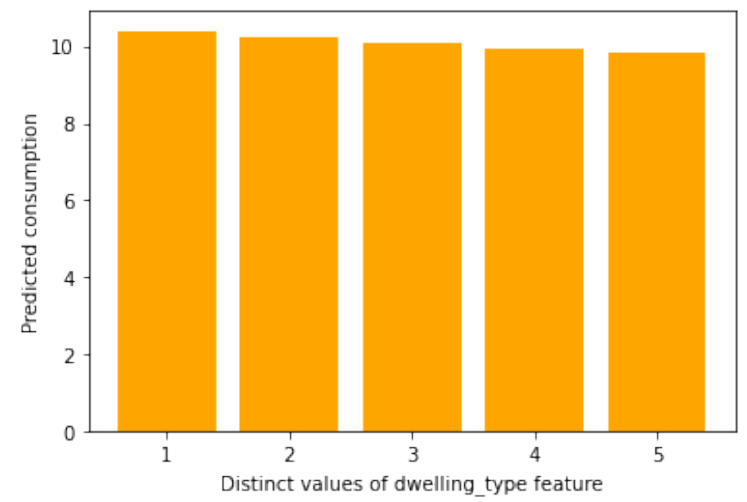
Figure 11. Impact of the dwelling type on the energy